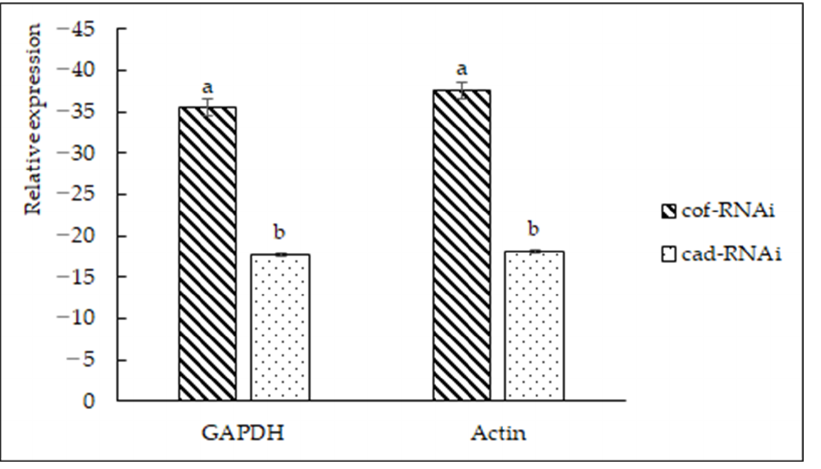
Figure 6. Relative expression levels of CCoAOMT2 and CAD5 genes. There are significant differences in the relative expression of different lowercase letters ( p < 0.01).